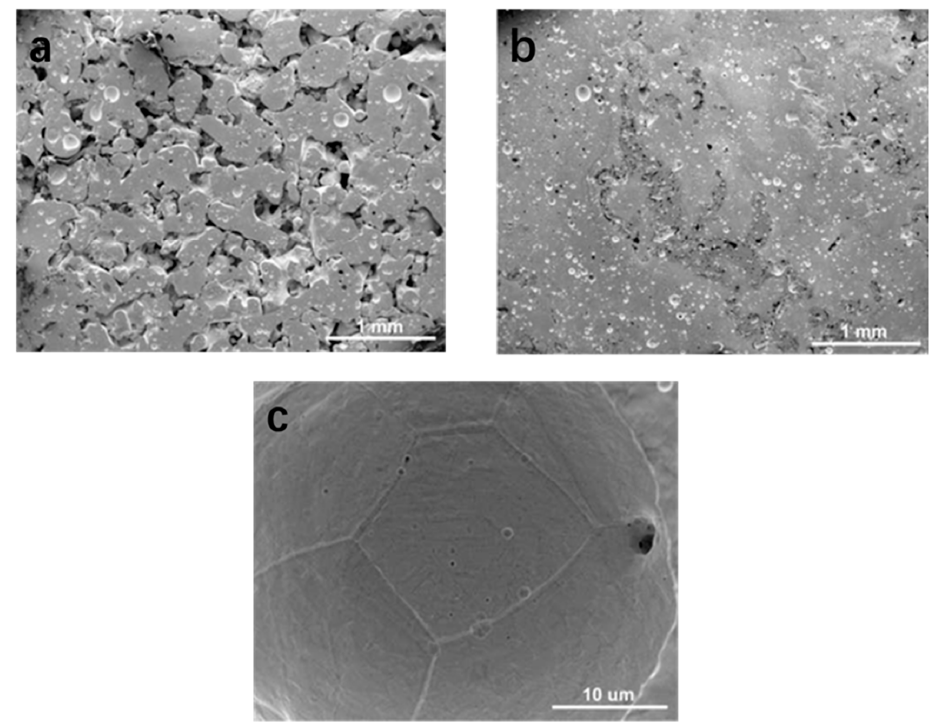
Figure 3. Microstructural study of Ta: ( a ) FESEM microstructure of porous tantalum structures; ( b ) ( b ) porosity characteristics of 55% and 73% dense samples; ( c ) Lens Grain™-processed porous Ta